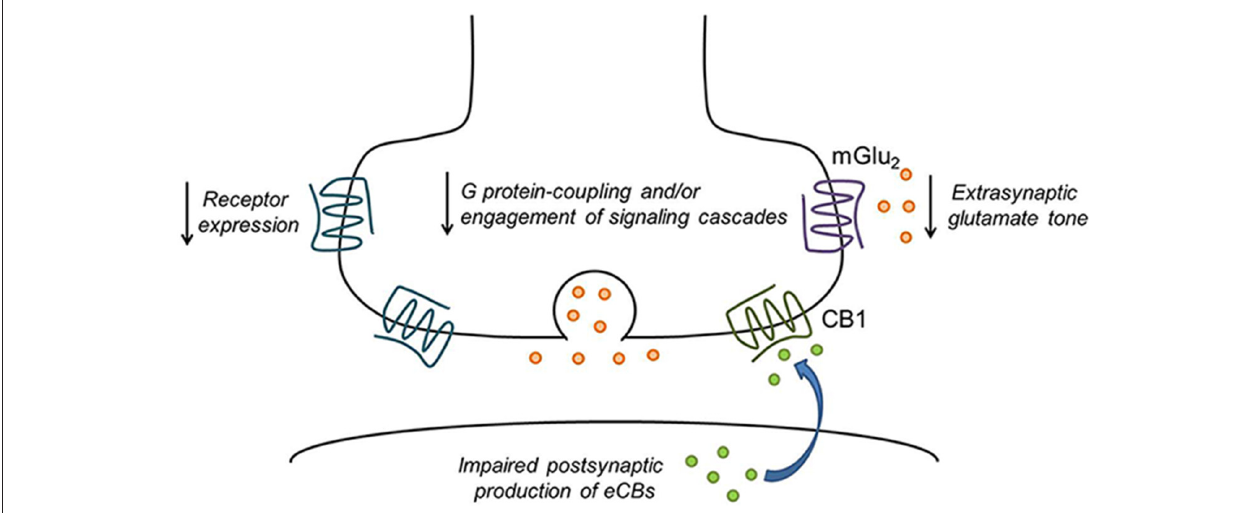
FIGURE 2 | Drug exposure disrupts presynaptic GPCR function. A variety of mechanisms may be involved in drug-induced reductions in presynaptic inhibition of neurotransmitter release. These include reduced receptor expression or surface levels and impaired coupling to G proteins or activation of intracellular signaling cascades. CB1 receptor signaling may also be reduced due to deficits in postsynaptic endocannabinoid (eCB) production. In addition, reduced cystine/glutamate exchange leads to decreased tonic activation of perisynaptic mGlu 2 / 3 in the nucleus accumbens (NAc). Finally, chronic drug exposure could cause long-term depression (LTD) of neurotransmitter release that occludes further synaptic modulation by